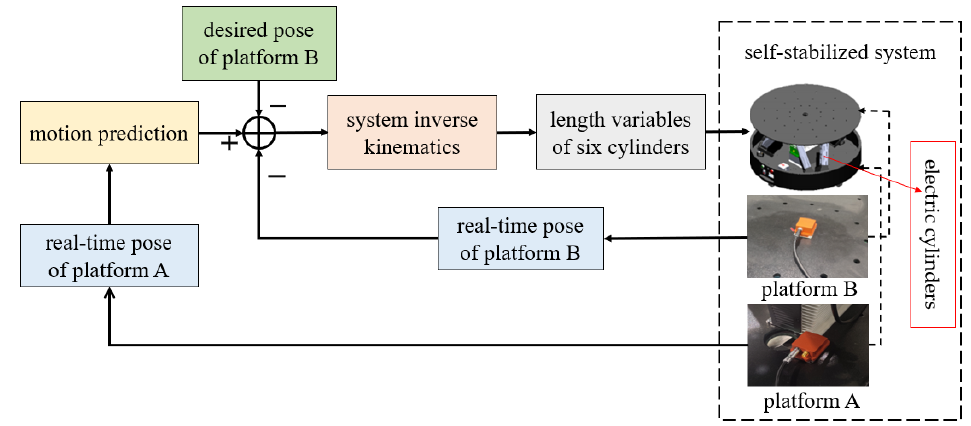
Figure 3. Motion compensation control method of the Self-Stabilized system.